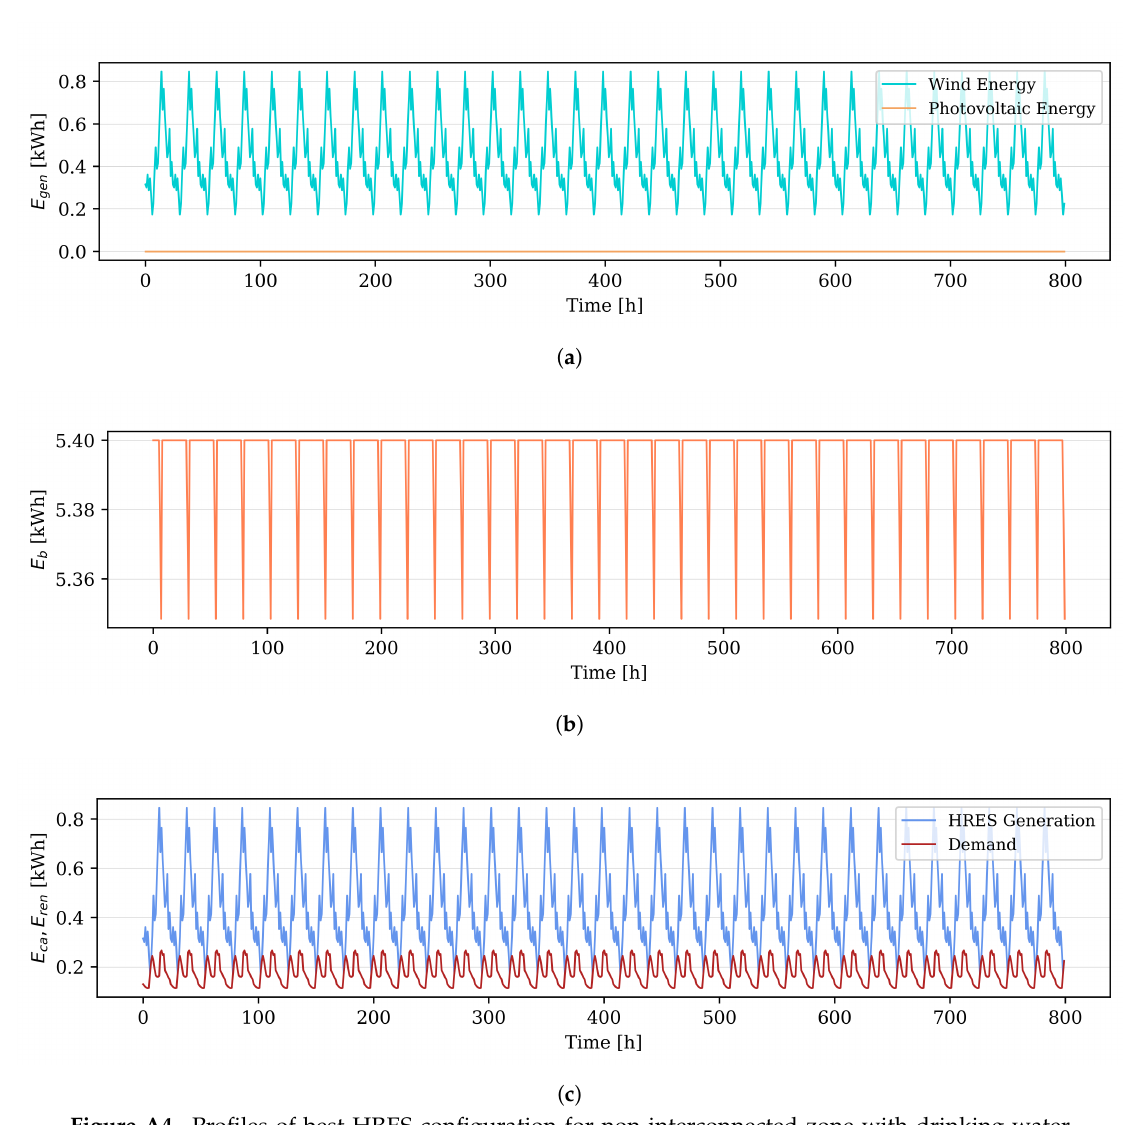
Figure A4. Profiles of best HRES configuration for non-interconnected zone with drinking water consumption (4.27 kW-h/day) obtained by single-objective function LPSP , N wt ,2 = 1, N b = 4. ( a ) Total renewable energy generation. ( b ) Storage system state. ( c ) HRES generation vs.